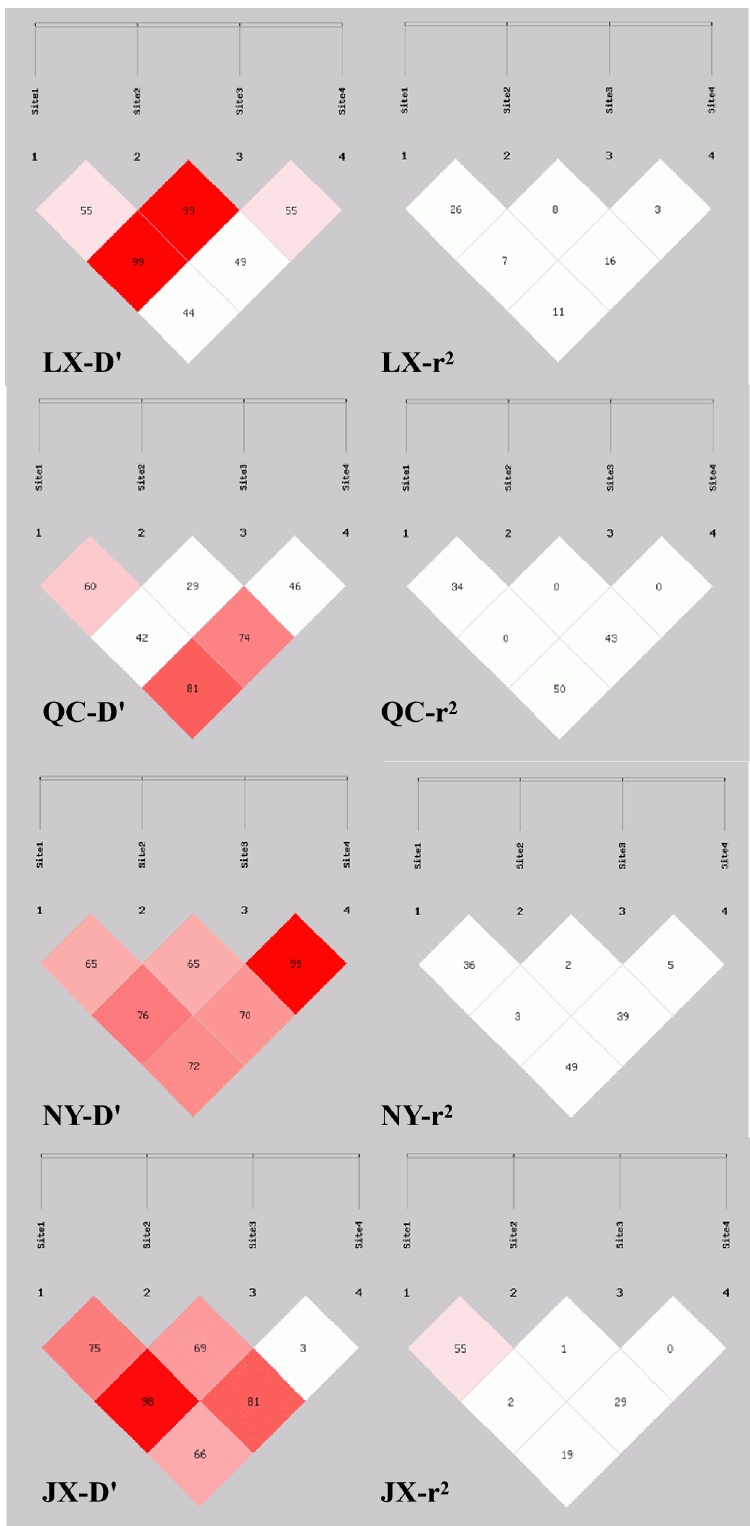
Figure 3. Linkage disequilibrium plot of four indel loci in cattle MSRB3 gene.